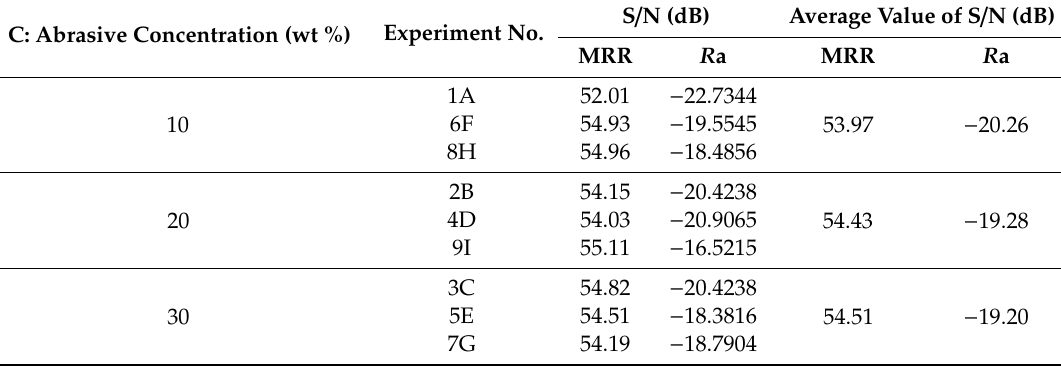
Table 5. Average value of S / N of abrasive concentration.